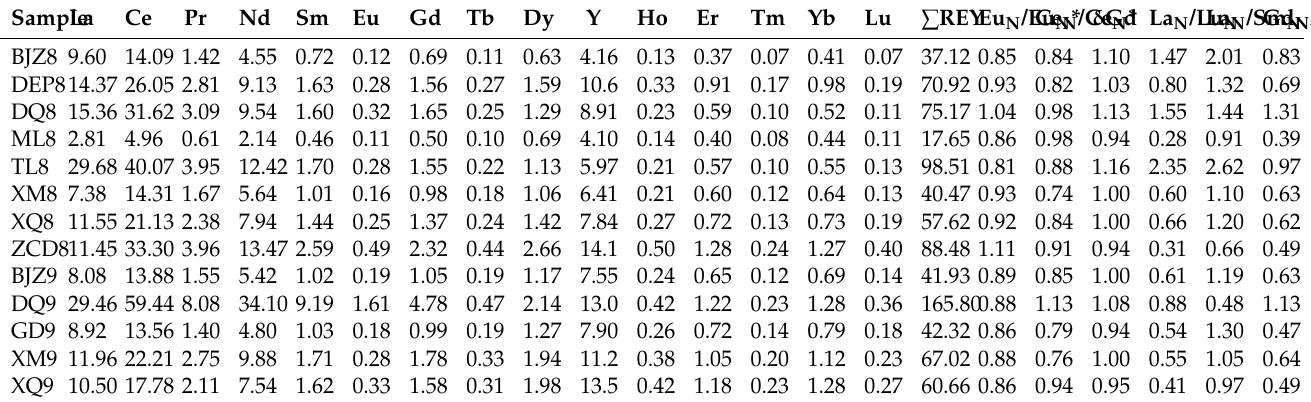
Table 7. Rare earth element content of coal samples ( µ g/g).